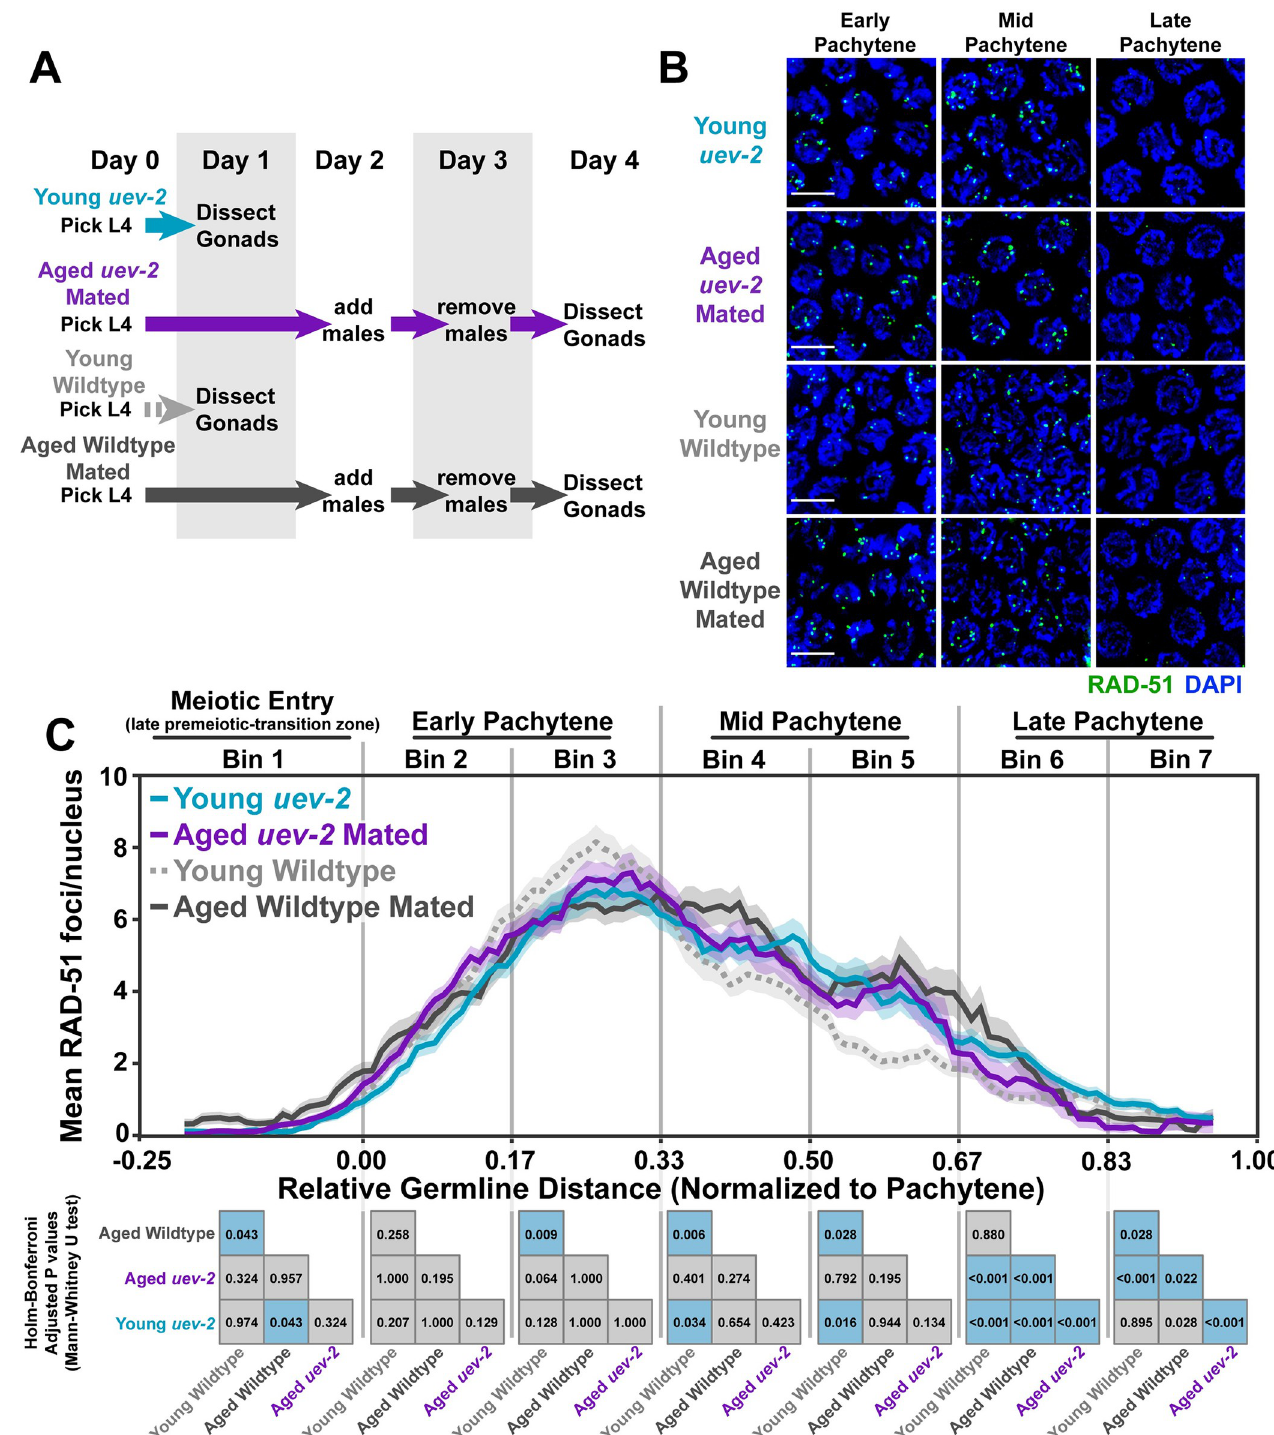
Fig 5. UEV-2 is required for ‘youthful’ DNA repair. A) Schemes used to isolate young (1 day post-L4) and aged (4 days post L4) uev-2 mutant worms for experiments. Days count ~18–24 hour periods after hermaphrodites were isolated as L4 larvae and are separated by alternating grey shaded boxes. B) Representative images of RAD-51 foci in meiotic nuclei of young uev-2 , aged mated uev-2 , young wildtype, and aged mated wildtype germlines. Scale bars represent 5 μ m. C) RAD-51 foci per nucleus in oocytes. Line plots represent the mean RAD-51 foci per nucleus along the length of the germline in a sliding window encompassing 0.1 units of normalized germline distance with a step size of 0.01 germline distance units. Mean RAD-51 foci were calculated from